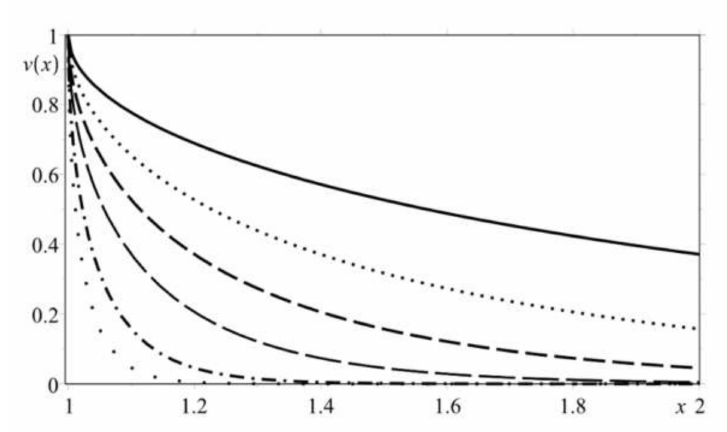
Figure 2. Dimensionless free surface displacements v ( x ) at x ∈ [ 1,2 ] for di ff erent values of d : 0.2 ( ——– ), 0.5 ( ·········· ), 1.0 (- - - -), 2.0 (– – –), 5.0 (– · – · –), and 10.0 ( ······